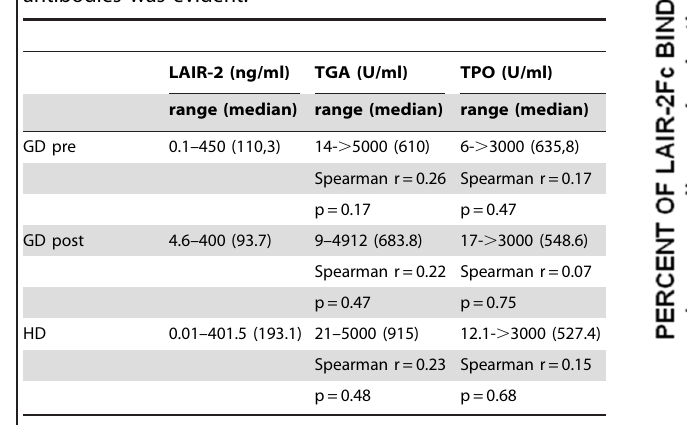
Table 1. No relationship between LAIR-2 and thyroid auto- antibodies was evident.